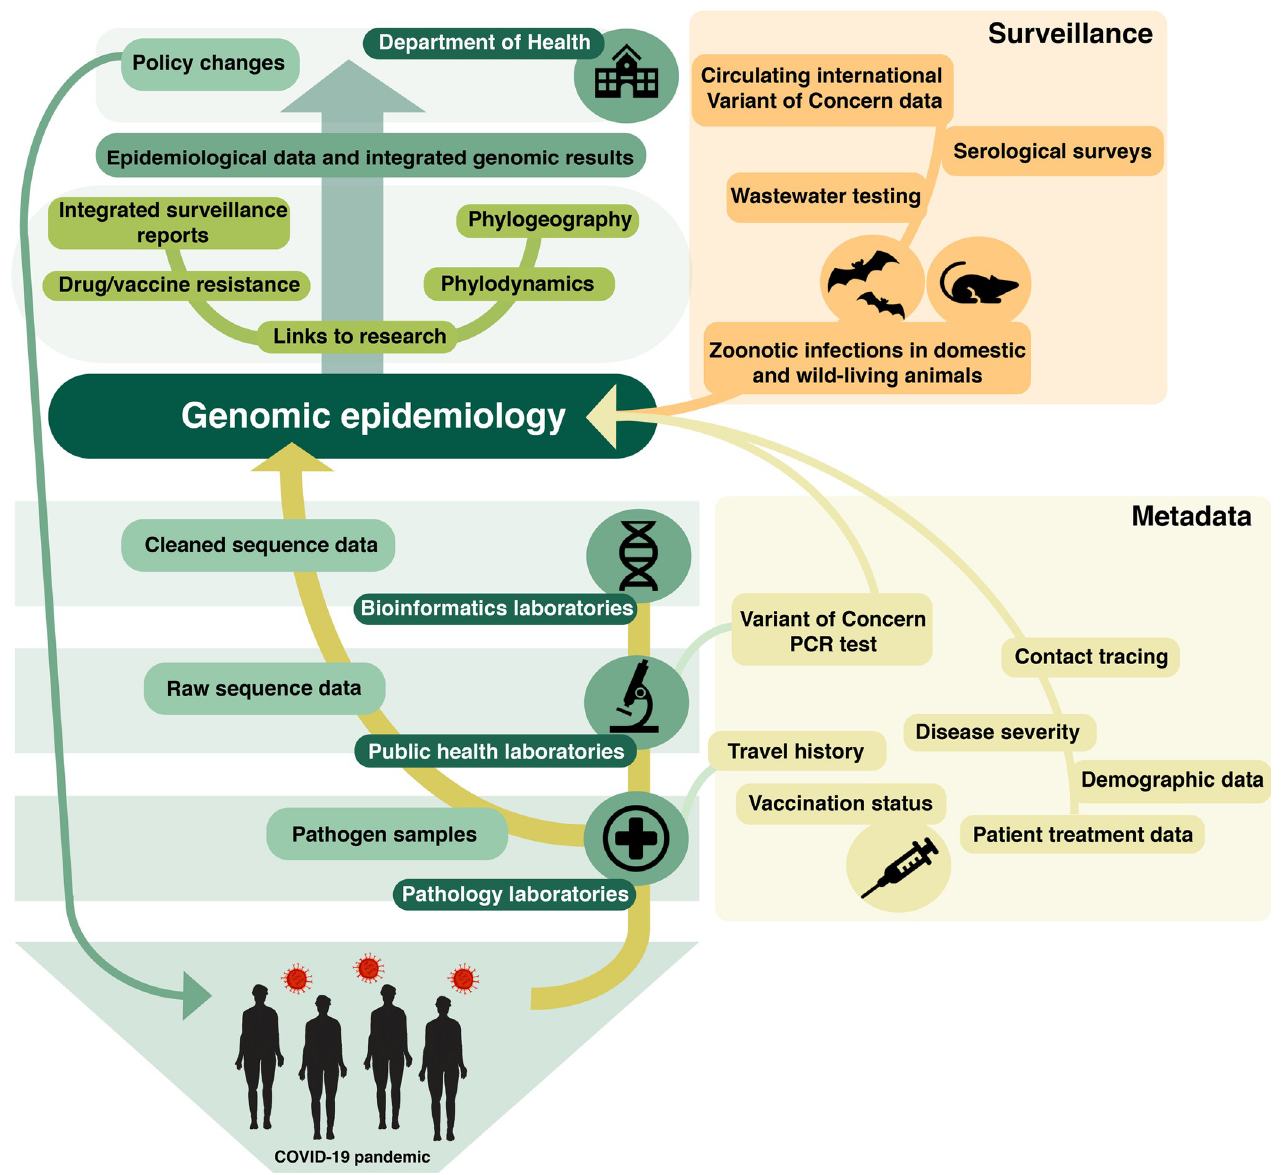
Fig 2. Visualisation of different sources of COVID-19 data, including sequence data and metadata, and how they feed into genomic epidemiology and link to research and policy making decisions. Here we highlight the flow and collaboration within the Australian COVID-19 pandemic response network, between public and private pathology, public and private pathology laboratories, bioinformatics laboratories, research groups and the health departments. The infographic on the left represents the pipeline of sequence data, sourced from samples collected from the public, feeding into genomic epidemiology and phylogenomic tools. The coloured bubbles on the right represent additional sources of data, such as epidemiological metadata (yellow bubbles) or global surveillance data (orange